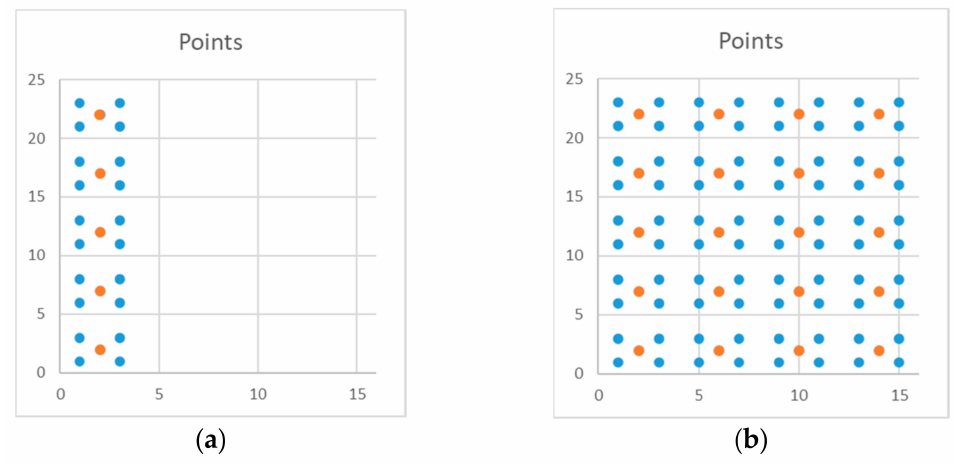
Figure 1. Examples of benchmark instances: ( a ) instance A; ( b ) instance D.